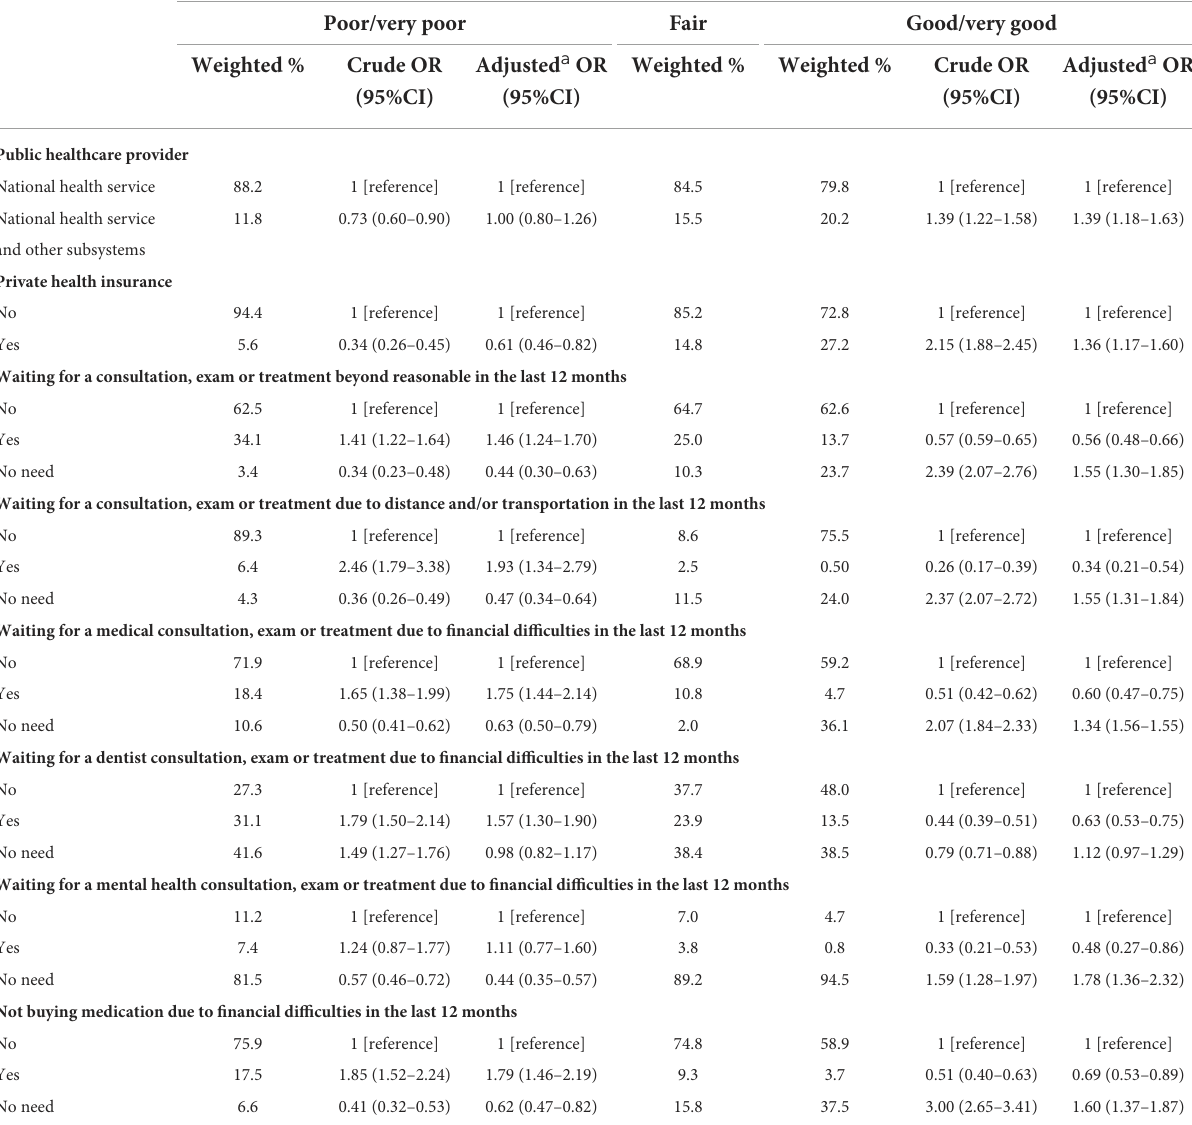
TABLE 4 Association between barriers to healthcare services utilization and self-perceived health status. Self-perceived health status Poor/very poor